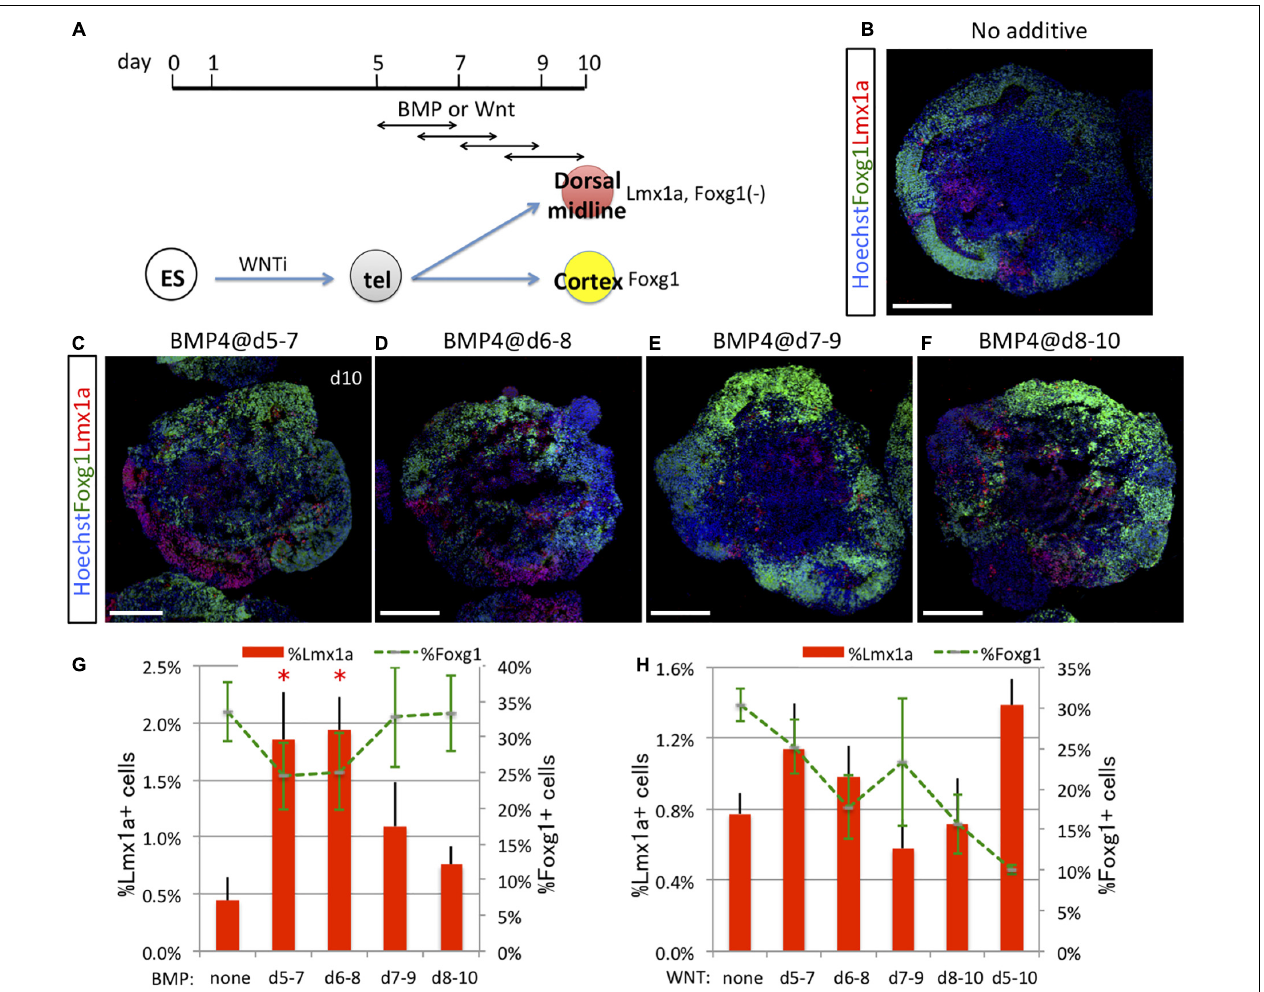
FIGURE 5 | Dorsal midline tissues were induced by timed BMP and WNT exposure. (A) Schematic of differentiation strategy for dorsal midline tissues and cortex. ES cells differentiated into Pax6 + /Foxg1 + cells (cortex) under the default condition (no additional cues) or into Lmx1a + dorsal midline cells by BMP or WNT signaling (dorsalization). (B–F) Using the 3D culture, we assessed the optimal time window for 2 days of BMP signal (BMP4 recombinant protein) exposure to induce dorsal midline tissues. Foxg1::venus cell aggregates cultured without BMP4 (B) or with BMP4 during days 5–7 (C) , 6–8 (D) , 7–9 (E) , or 8–10 (F) . Images show Foxg1::venus fluorescence (green) and immunostaining for Lmx1a (red). Lmx1a + cells (red) were induced in restricted patches but in contiguous arrangement with Foxg1 + cortical cells (green) as in vivo . Hoechst 33342 (blue), nuclear staining. Scale bars, 200 µ m. (G) Proportion (%) of subregional marker + cells among the whole aggregate; Lmx1a + (red bars) and Foxg1 + (green dashed line). (H) We analyzed the optimal time window for 2 or 5 days of WNT signal exposure to induce dorsal midline tissues using the WNT agonist CHIR99021. Proportion (%) of subregional marker + cells in aggregates; Lmx1a + (red bars) and Foxg1 + (green dashed line). Expressed as mean ± SEM ( N = 3). ∗ P <